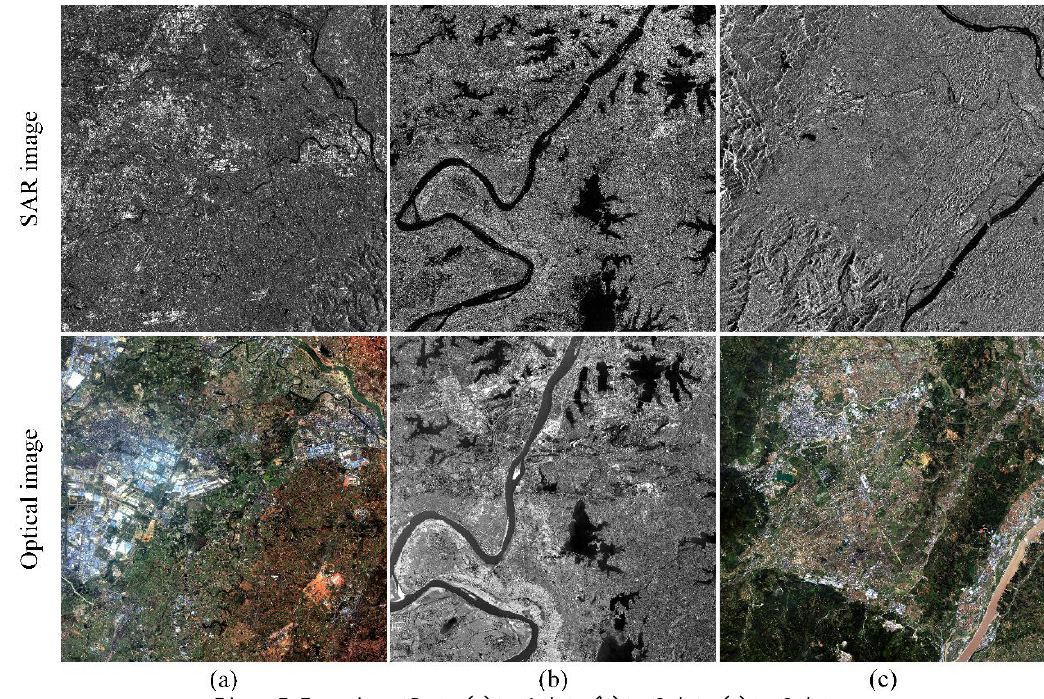
Figure 7. Experiment Data. (a) test1 data. (b) test2 data. (c) test3